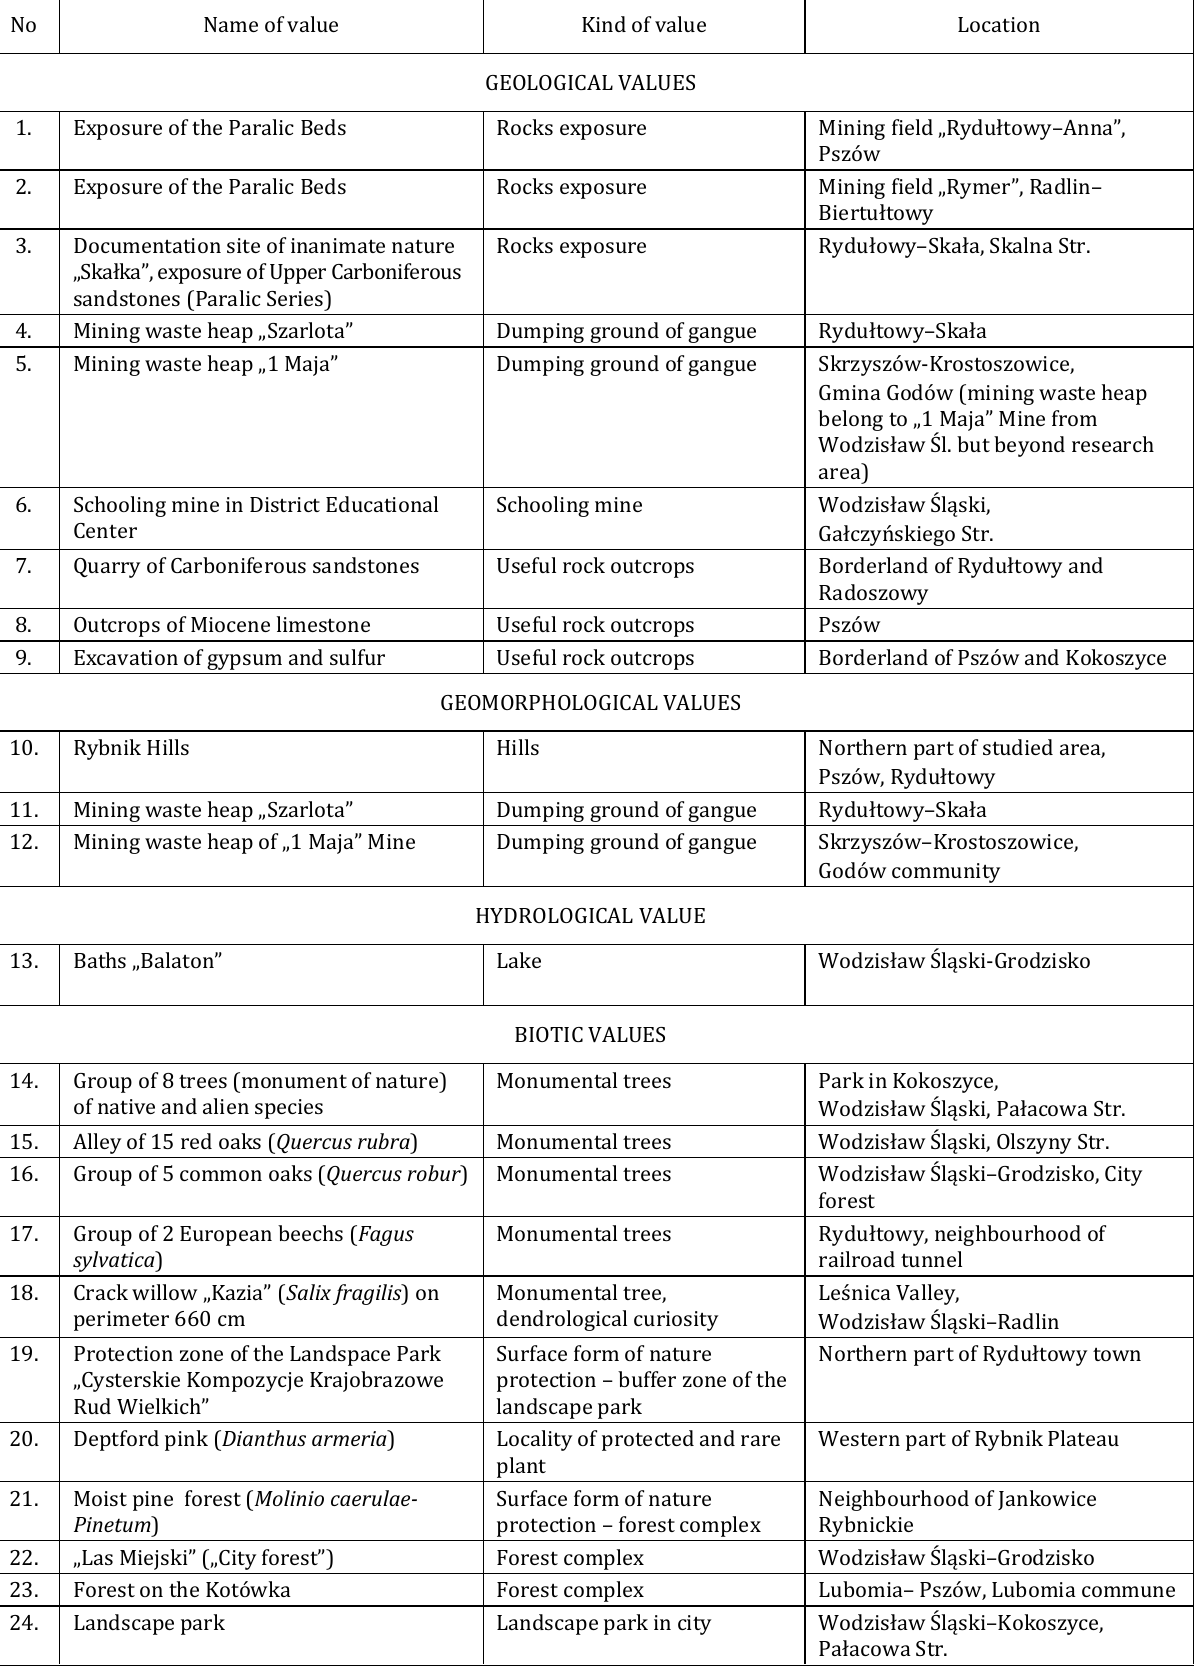
Table 2. Nature values in the mining towns – Wodzisław Śląski, Rydułtowy, Pszów and Radlin